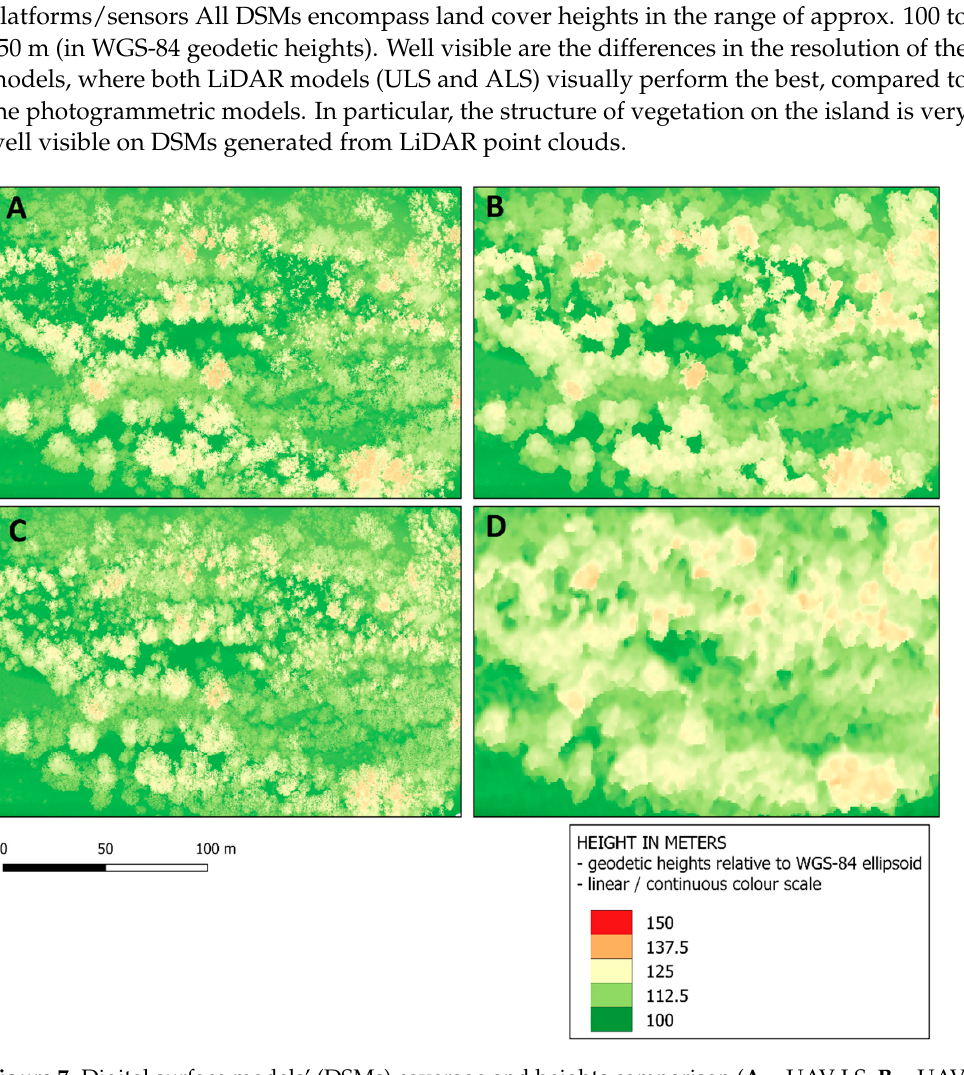
Figure 7. Digital surface models’ (DSMs) coverage and heights comparison ( A = UAV-LS, B = UAV- DAP, C = ALS, D = PLEIADES) on the example of Northern Island of the “Kie ł pi ń skie Shoals”. Resolution of the models is always 10 cm, except for the Pléiades model (50 cm).